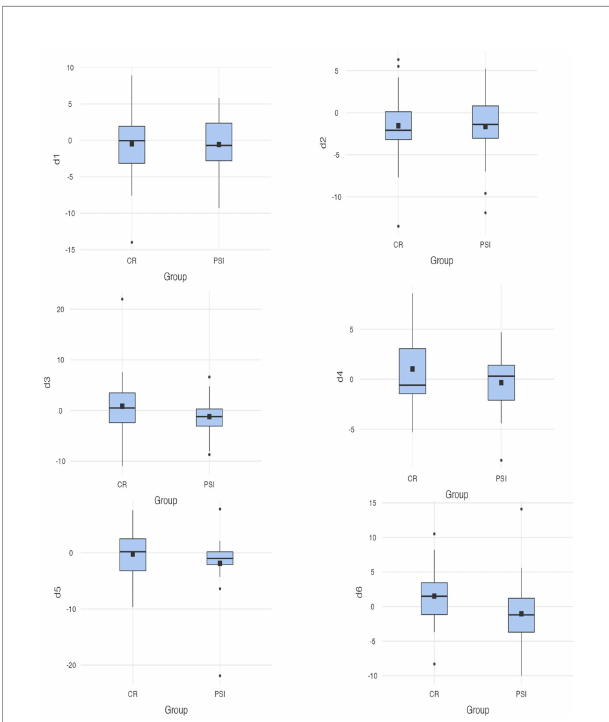
FIGURE 4 | Differences between the measurements (D1 – D6) for conventional reconstruction plates and patient-speci fi c implants; D6 [ t (56) = -2.217; p = . 031 <.